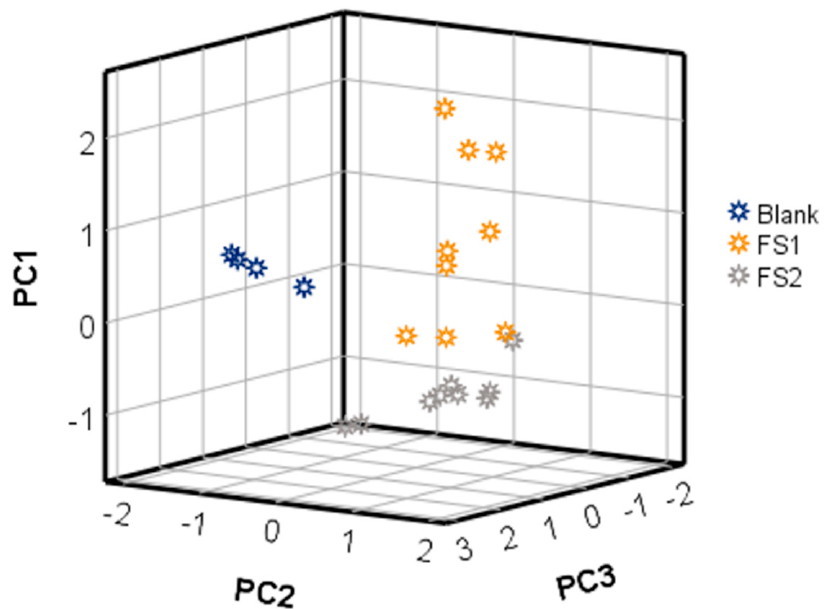
Figure 3. Graphical representation of samples according to the scores from principal components (PCs) 1 to 3 obtained from PCA (D 22X1020 ), where 22 is the number of armband samples, and 1020 is the number of drift times.